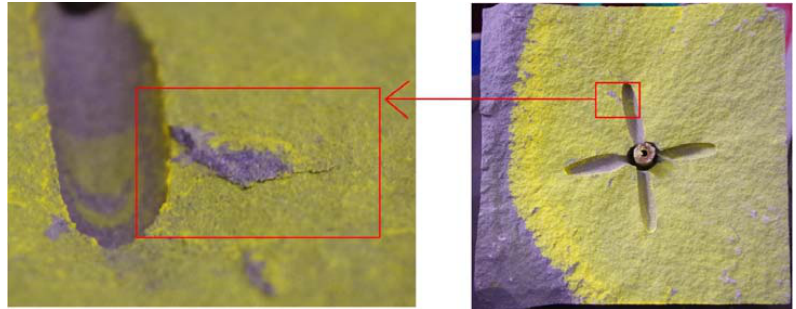
Figure 11. The details of secondary crack in four ‐ branched borehole model, and positions in the specimen.